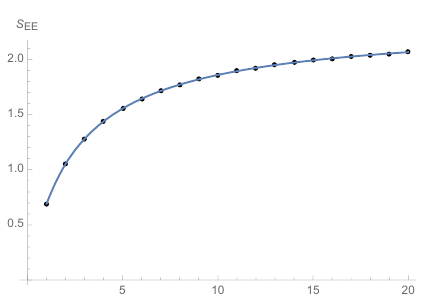
for the connected sum of two Hopf links as a EE ; L 2 L 1 ;L 3 j